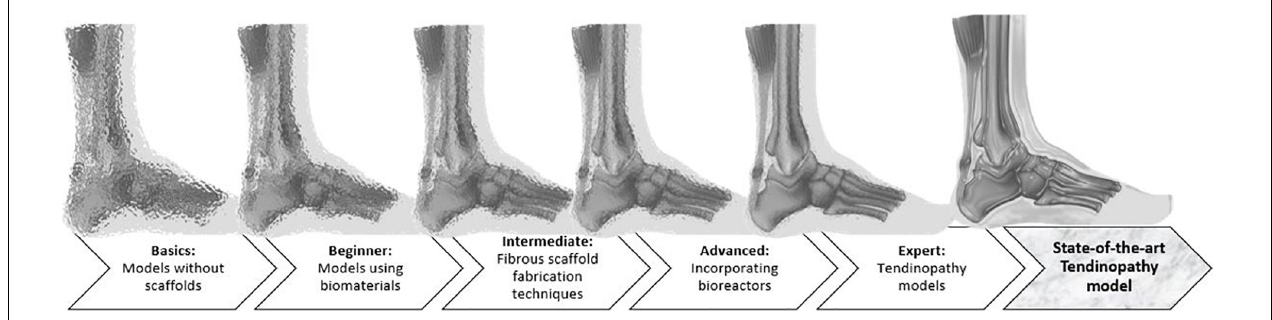
FIGURE 2 | Illustration of the review’ structure, starting from very basic but very unclear, blurred models to increasingly complex models, which are more appropriate to represent an injured Achilles tendon and to clarify the MSC mechanisms of